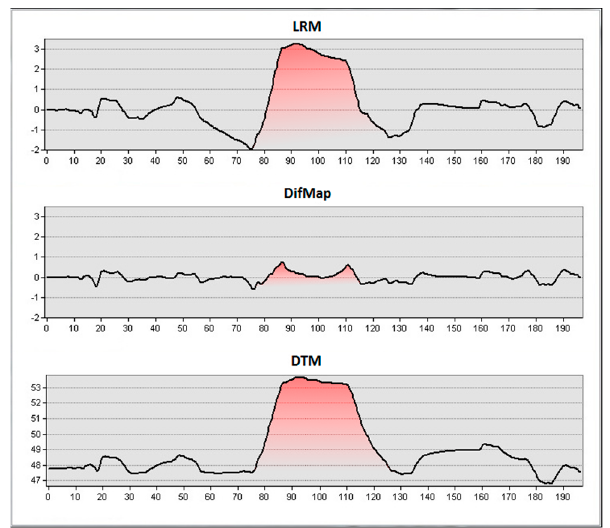
Figure 10. Profile graphs of the motte in Borken in the LRM ( top ), Difference Map (DM) ( center ) and DTM ( bottom ). The motte is highlighted in red [13].